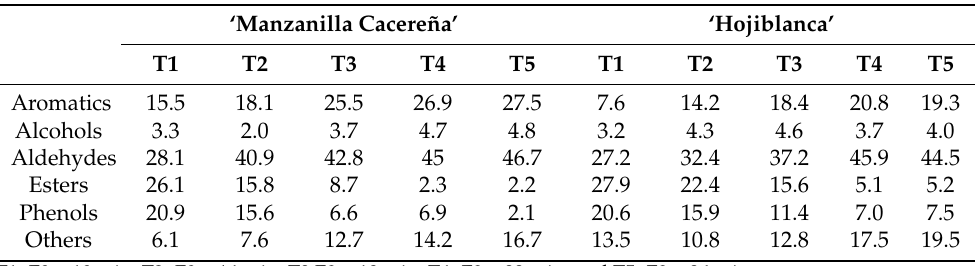
Table 2. Distribution (%) of chemical families of volatile compounds in Californian-style black olives (“Manzanilla Cacereña” and “Hojiblanca”) submitted to sterilization treatments (T1–T5). ‘Manzanilla Cacereña’